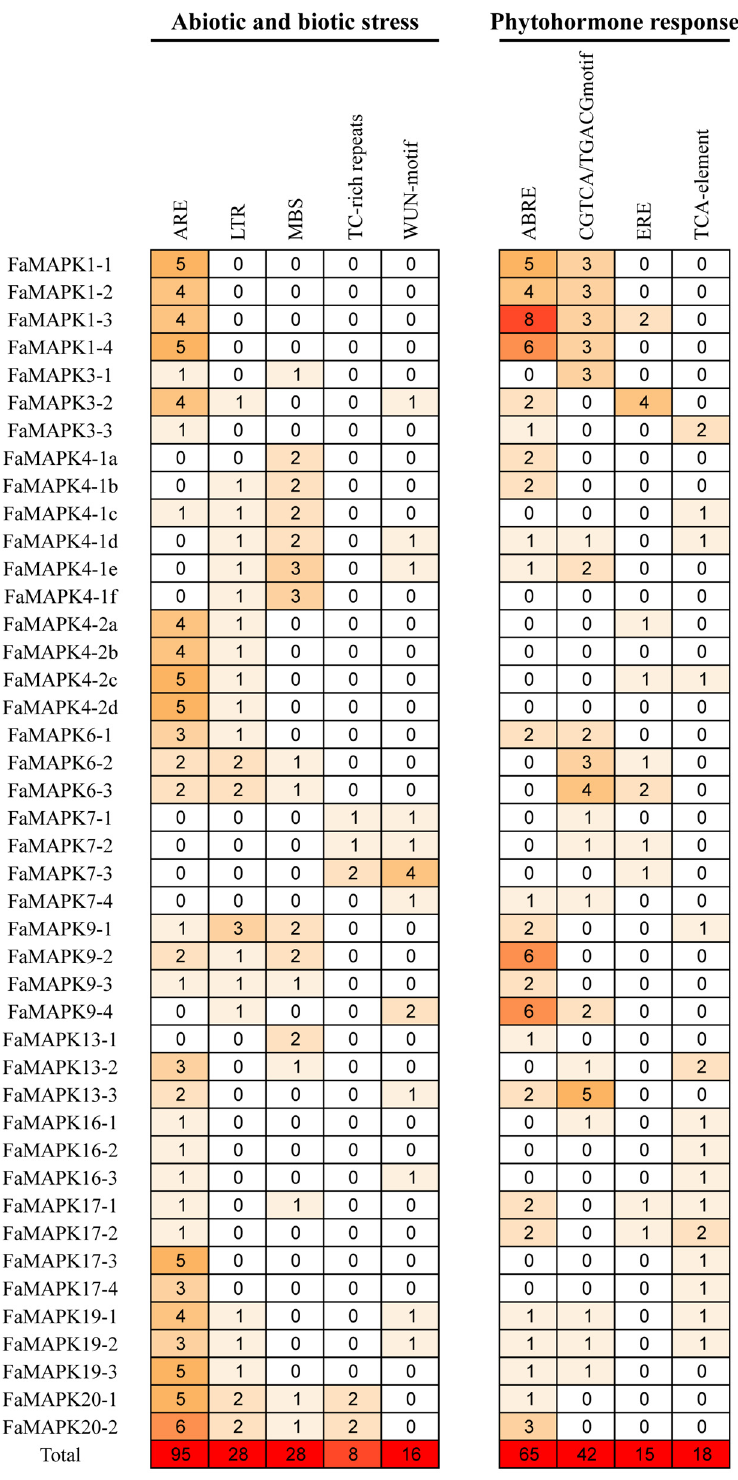
Figure 6. Analysis of cis -regulatory elements in the promoter regions of FaMAPK genes. The figures indicate the number of each cis -regulatory element in the promoter region (1.5 kb upstream of the translation start site) of the FaMAPK genes. Based on functional annotations, the cis -regulatory elements can be classified into two major classes: phytohormone response-related, and abiotic and biotic stresses-related cis-elements.